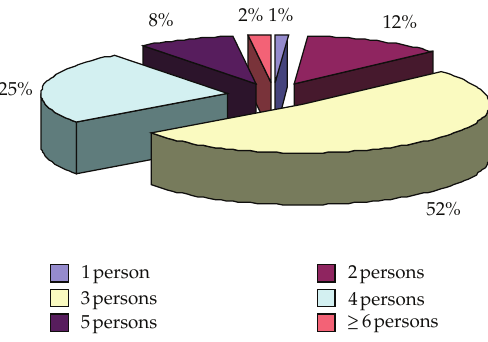
Figure 2: Household size